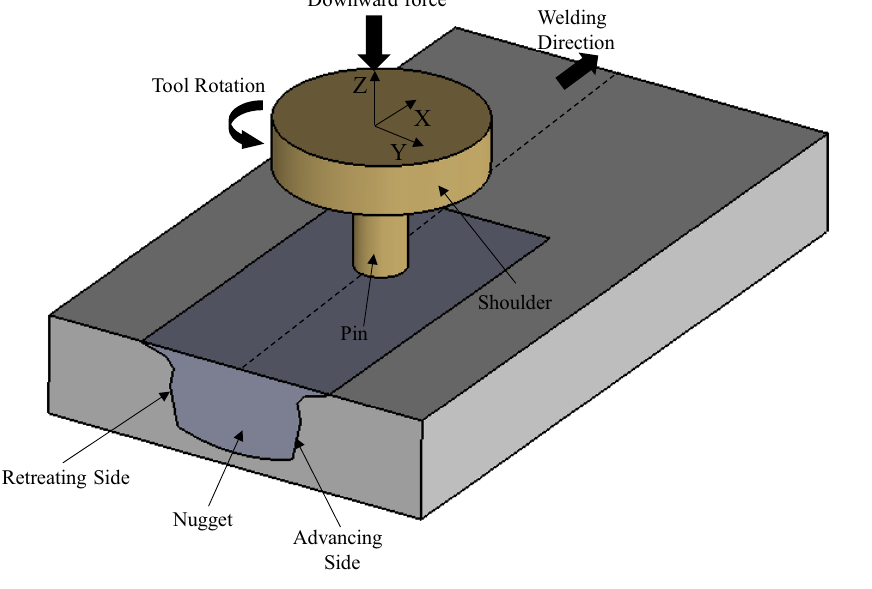
Figure 1. The FSW process